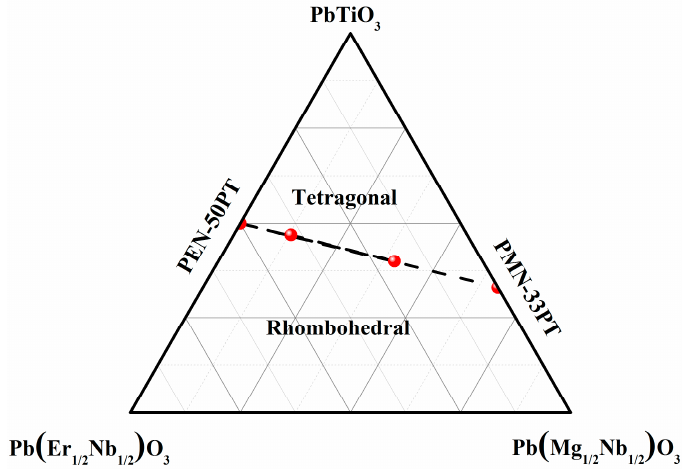
Figure 1. Phase diagram of PEN-PMN-PT ternary system.